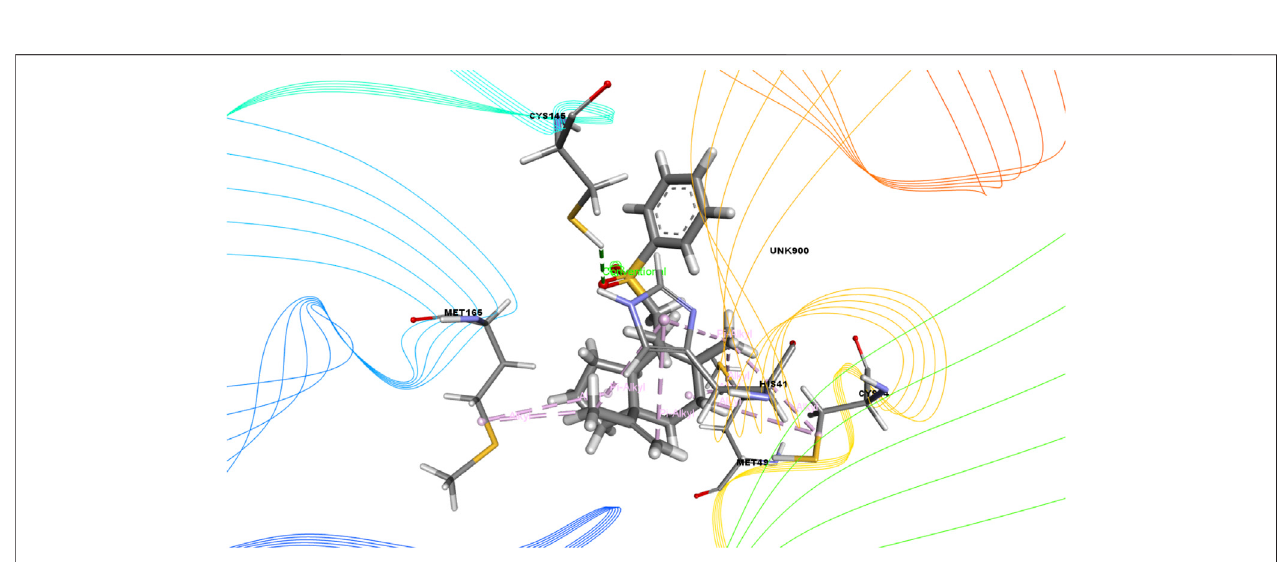
FIGURE 3 | 3D interactions of Bicyclo[4.3.0]nonane, 1 isopropenyl-4,5-dimethyl-5-phenylsulfonylmethyl with the active site of SARS-CoV-2 main protease (PDB ID: 6W63).